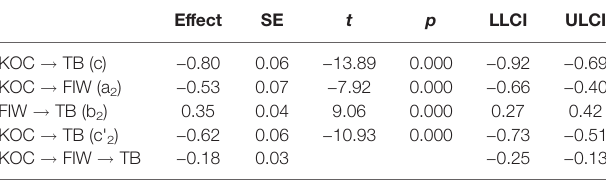
TABLE 5 | Mediating effect of FIW.